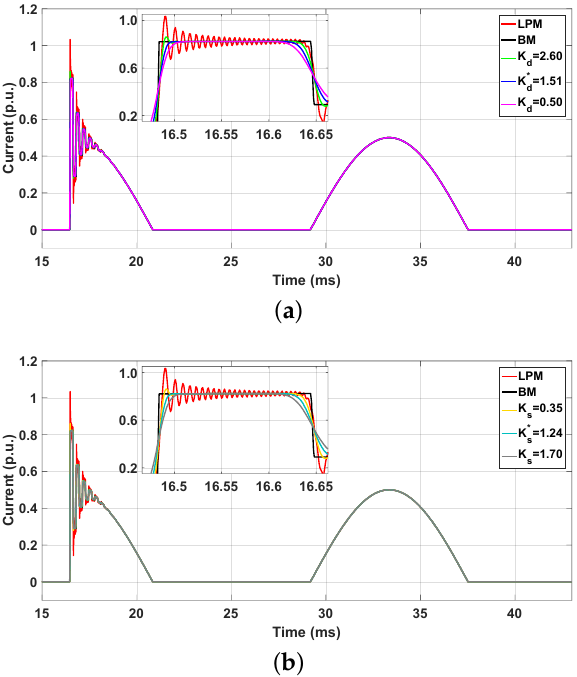
Figure 11. I m ( t ) for the 80-km single-phase TL in scenario 3: ( a ) LPM, BM and T 1 and ( b ) LPM, BM and T 2